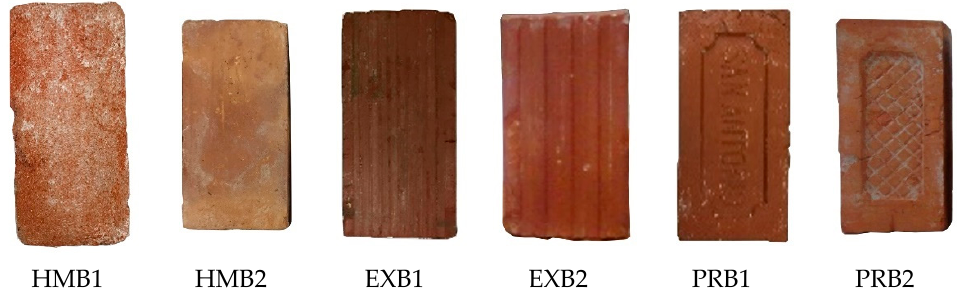
Figure 2. Photographs and denomination of the different bricks.